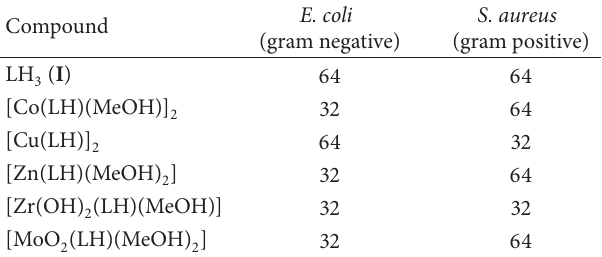
Table 4: Minimum inhibitory concentration (MIC) of ligand ( I ) and its coordination compounds ( 𝜇 g/mL).